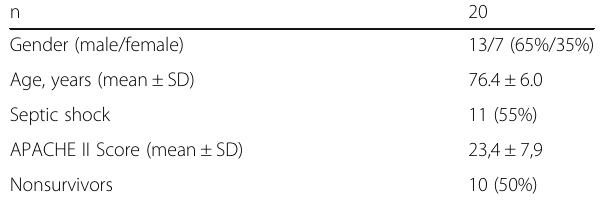
Table 4 Whole blood samples: Characteristics of Sepsis Patients